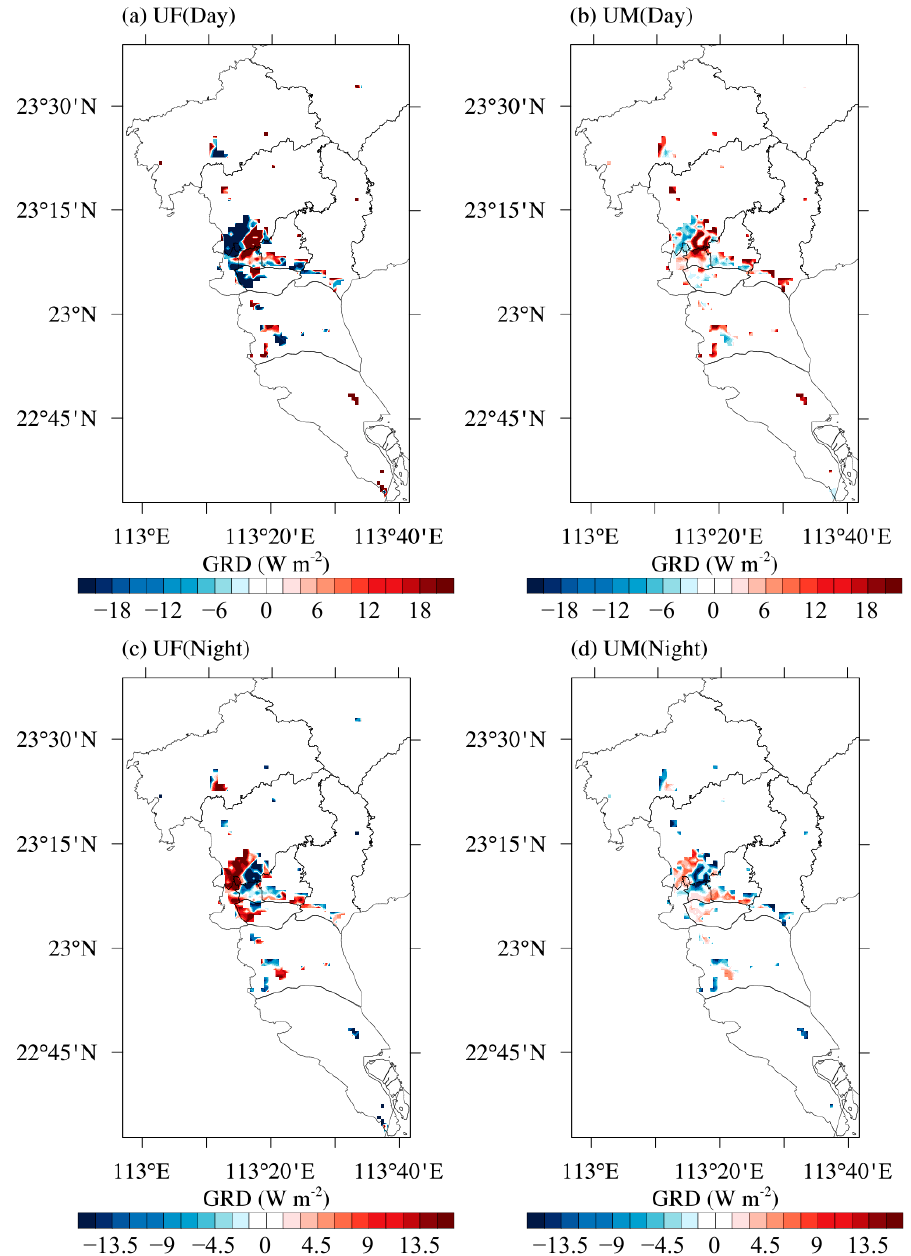
Figure 6. Effect of high-resolution UF and UM on the daytime and night-time ground heat flux (GRD) in the underlying urban surface of Guangzhou. Here, the impacts of UF/UM during daytime were calculated by comparing the simulated hourly GRD values from 08:00 LST to 16:00 LST for 10 days (from 1 to 10 November) in two experiments and then averaging the result. Meanwhile, those during the night-time were derived using the data from 17:00 LST to 07:00 LST. ( a , c ) Effect of UF (Case 1–Base); ( b , d ) effect of UM (Case